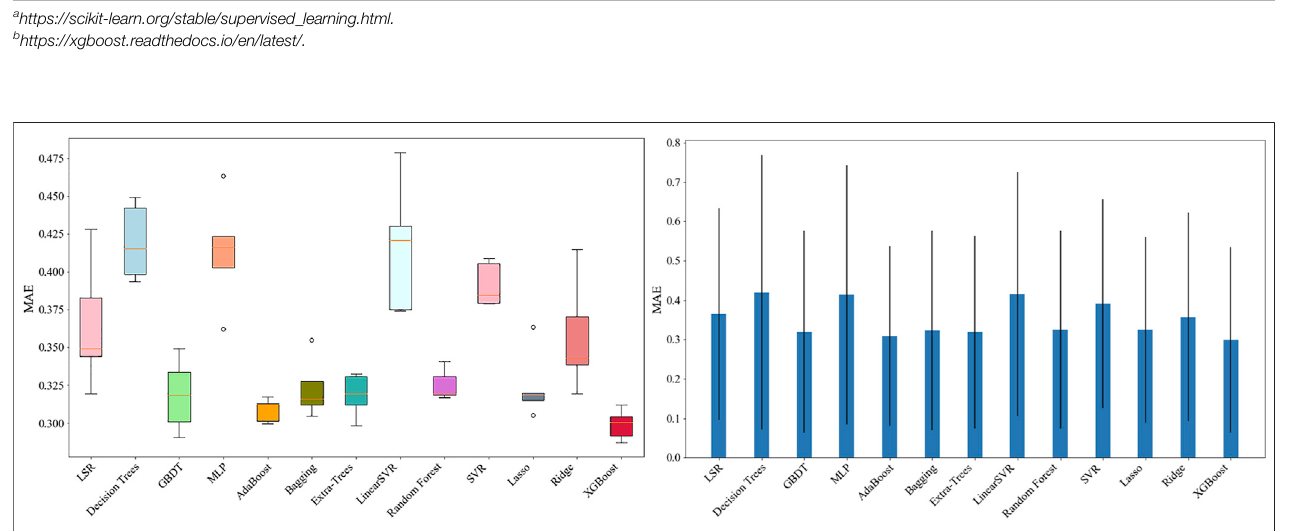
Frontiers in Physiology |